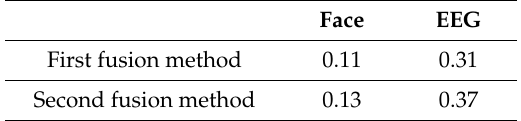
Table 6. The results of statistical tests in the DEAP dataset in valence